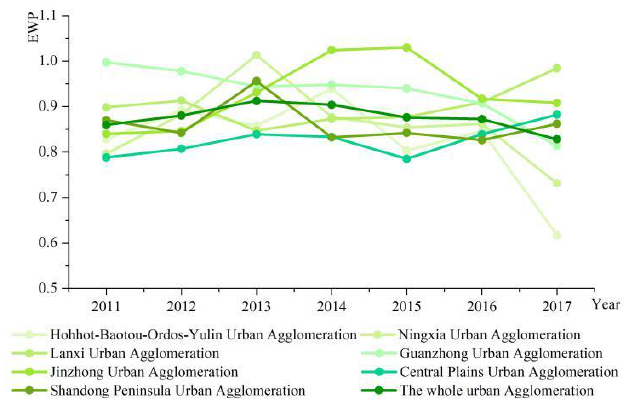
Figure 5. The EWP of the seven urban agglomerations in the Yellow River Basin from 2011 to 2017. From 2011 to 2014, except for Guanzhong Plain Urban Agglomeration and Lanxi Urban Agglomeration, the other five urban agglomerations showed an upward trend. Among the urban agglomerations, the EWP of Ningxia Urban Agglomeration along the Yellow River Basin increased from 0.796 in 2011 to 1.013 in 2013, and it increased 27.3%. From 2014 to 2017, except for Lanxi Urban Agglomeration and Central Plains Urban Agglomeration, the EWP of all urban agglomerations showed a significant downward trend.